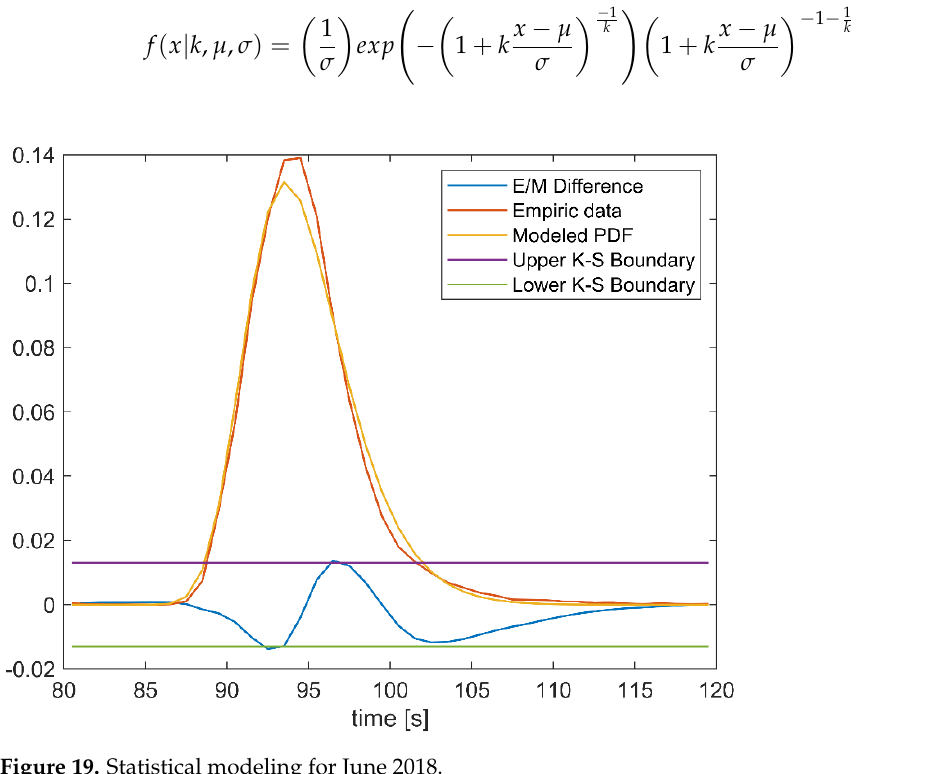
Figure 19. Statistical modeling for June 2018.